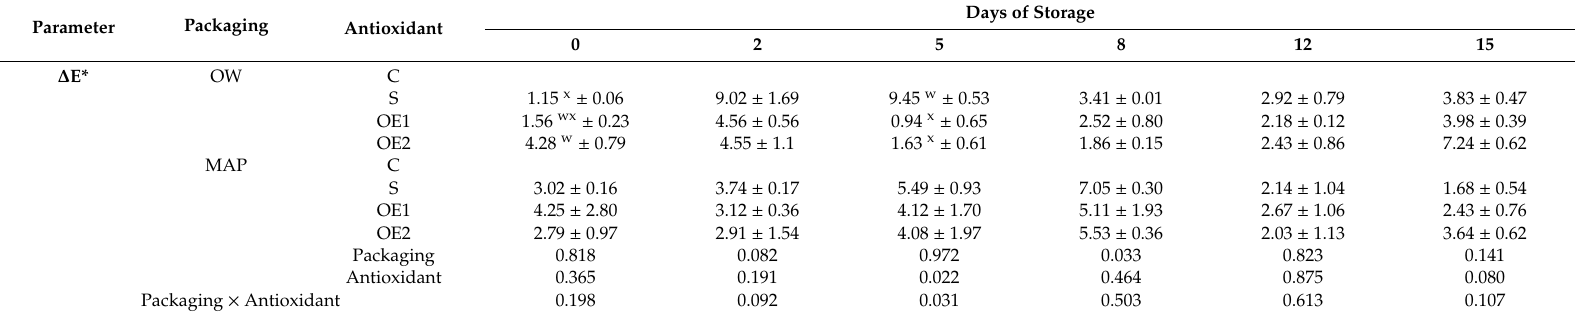
Table 4. The total color di ff erence parameter ( ∆ E*) between the control patties and the patties with antioxidants α packed under di ff erent conditions β during storage at 4 ◦ C.